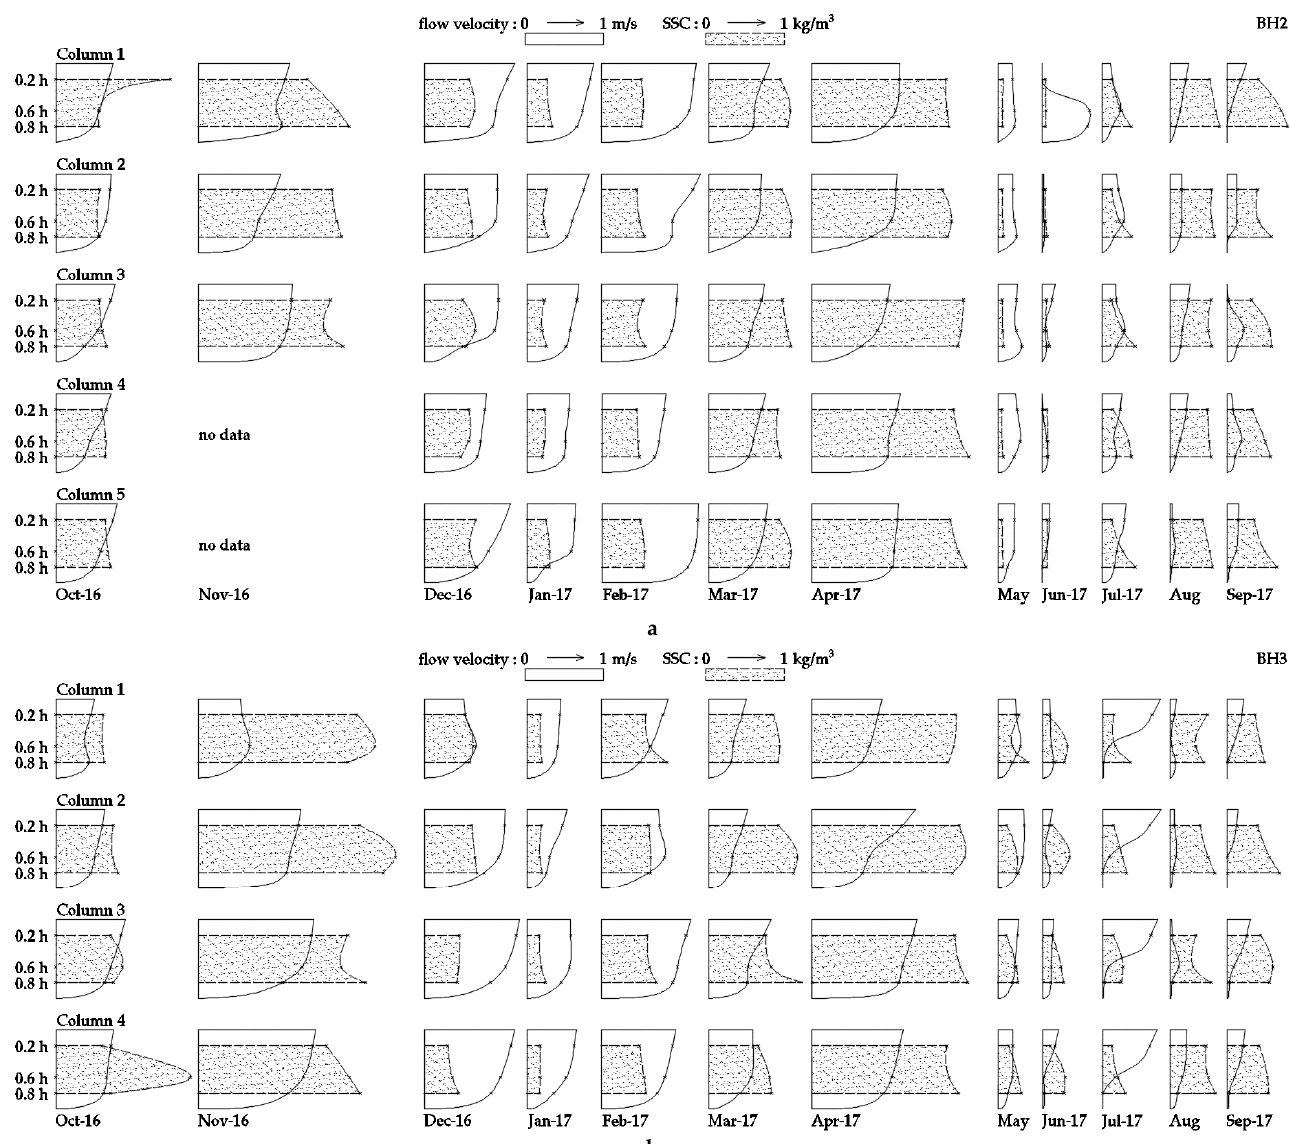
Figure 6. Correlation between SSC and flow velocity at BH2 ( a ) and BH3 ( b ). Ji et al. [25] proved that some types of sediment transport were simulated based on the flood hydrograph at Nakdong River Estuary Barrage. Observing BH3, the sediment transport rate also varied during the rainy season. In November, the expressive tendency of the sediment transport rates was caused by vulnerable erosion at the river branch and supported by the high flow velocity, except on column 1. It was located beyond the inner bend of the river, which slightly curved when observed spatially. In contrast, the slower flow velocity in the dry season (May–September 2017) showed a higher sediment transport rate in July–September at BH2. Two months of sediment transport, in May and June, were smaller because the saline content at the location had not intruded at that time when sampling (Table